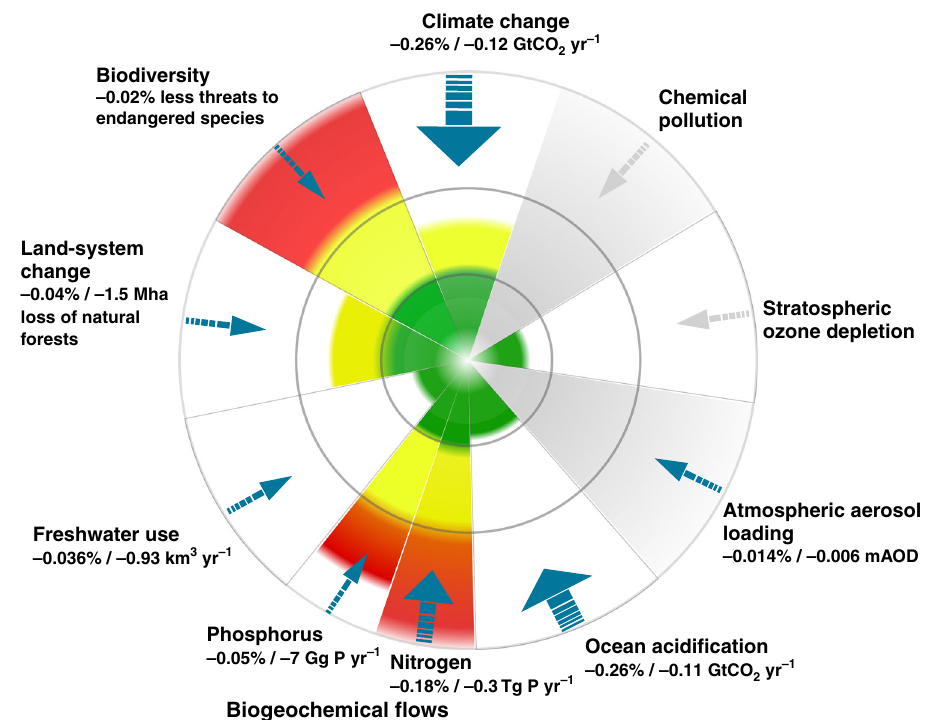
Fig. 3 Change in planetary pressures resulting from a one percentage point increase in the tax on carbon and a one percentage point reduction of biofuel subsidies. This fi gure is a modi fi cation of the original planetary boundary fi gure from refs. 1,3 . The colors indicate the current state for each boundary: green, yellow, and red correspond to safe, increasing risk and high risk, respectively. We have added arrows illustrating the effects on each individual ESP, from increasing the tax rate on carbon by one percentage point and reducing biofuel subsidies by one percentage point in our integrated model of the global economy and the ESPs. Interpretation is otherwise the same as in Fig. 2. Further details are given in Supplementary Table